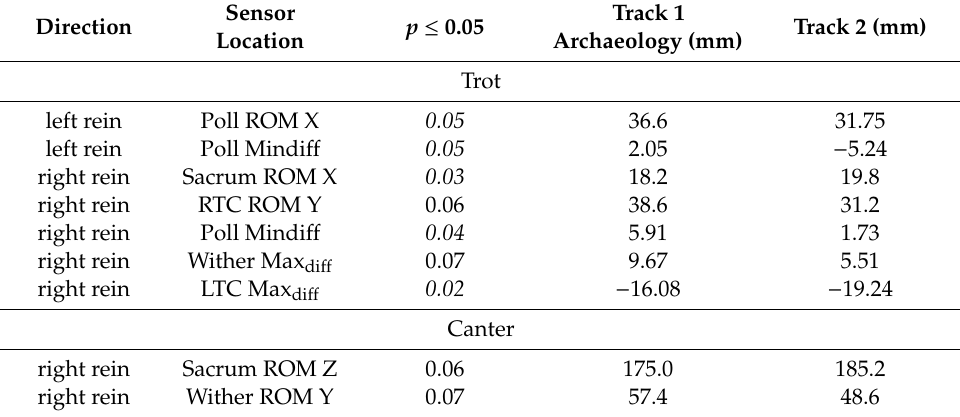
Table 2. Kinematic data from the IMU sensors collected during trot and canter for both left and right rein on Track 1 and Track 2, (ROMY = range of motion in mediolateral direction, ROMX = range of motion craniocaudal direction ROMZ = range of motion in vertical direction, MinD i ff = di ff erence between the two minima in vertical displacement, MaxDi ff = di ff erence between the two maxima in vertical